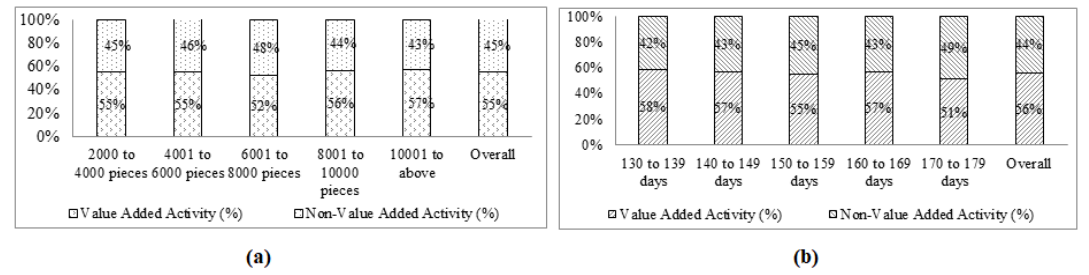
Figure 5. Non-value-added and value-added activities depending on (a) quantity and (b) lead